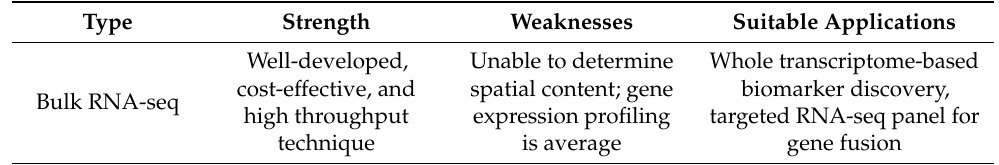
Table 2. Advantages and limitations of RNA-Seq techniques for spatial mapping of biomarkers used in clinical